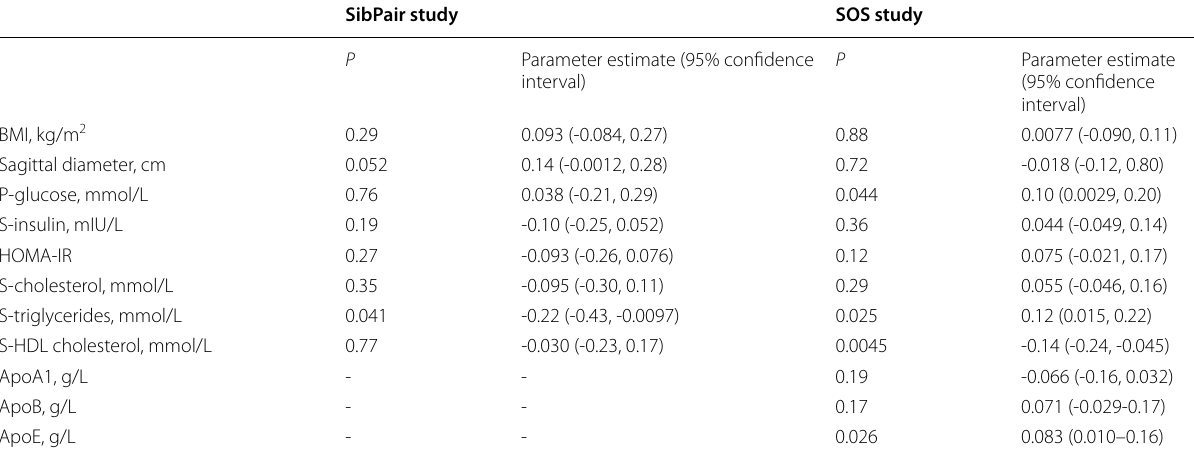
P -values and parameter estimates for the associations between the rs11024595 SNP and investigated cardiovascular risk factors in the SibPair study and the SOS study. The analyses were adjusted for age, sex and BMI except for analysis including indices of adiposity where only adjustment for age and sex was performed. Additional adjustment for non-independence among related individuals was applied in the SibPair study. The parameter estimates are used as an indication of the impact that the rs11024595 SNP has on a